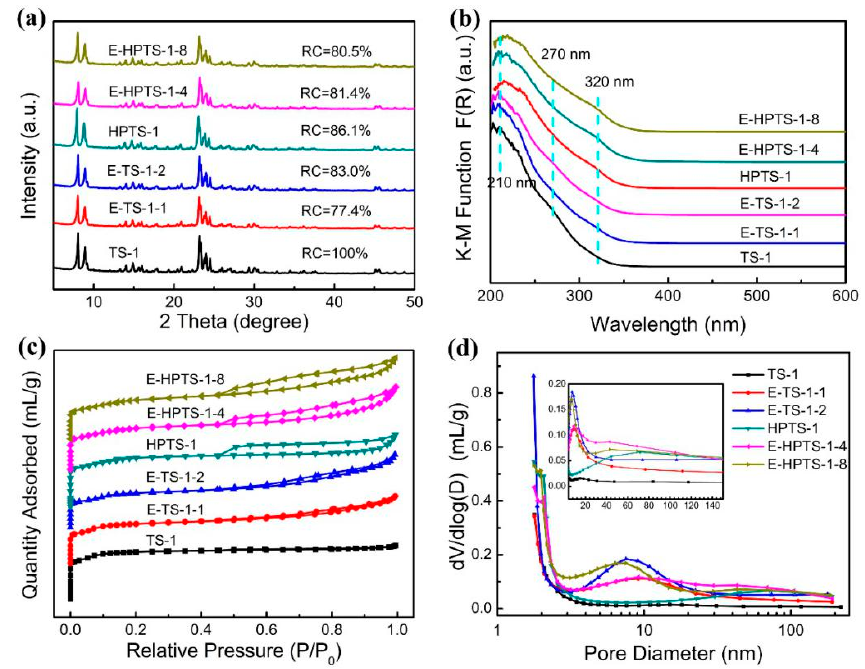
Figure 1. SEM ( a , b ) and TEM ( c , d ) images of TS-1 and hierarchically porous titanium silicalite-1 (HPTS-1) samples.